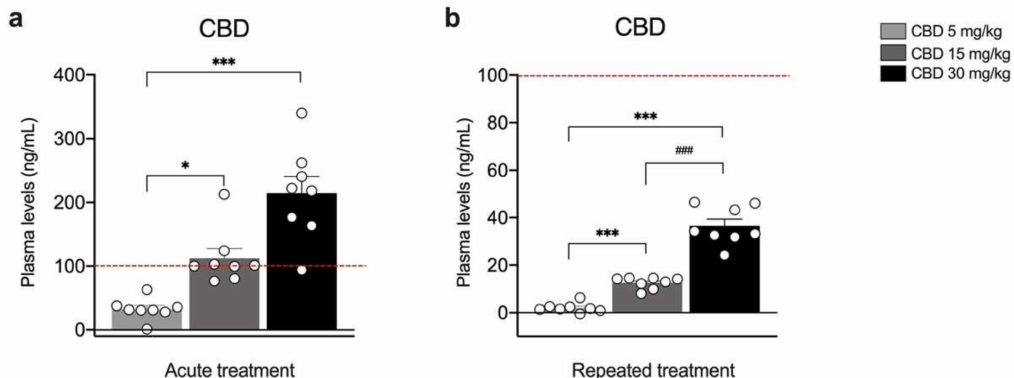
Figure 1. Concentration of CBD in the plasma of rats treated with a single ( a ) or repeated ( b ) CBD administration at the dose of 5 mg/kg, 15 mg/kg, or 30 mg/kg and killed respectively one ( a ) and twenty-four hours ( b ) after the last treatment. Bar graphs represent the mean ± SEM from eight independent determinations for each experimental group. Red dashed line in panel a indicates the y axis limit (100) of the bar chart represented in panel b. Ordinary one-way ANOVA followed by Tukey’s multiple comparisons test, or Kruskal − Wallis one-way ANOVA for ranks followed by Dunn’s multiple comparisons test for non-normally distributed data. * p < 0.05, *** p < 0.001 vs. 5 mg/kg, ### p < 0.001 vs. 15 mg/kg. CBD 5 mg/kg n = 8 CBD 15 mg/kg n = 8, CBD 30 mg/kg n = 8.